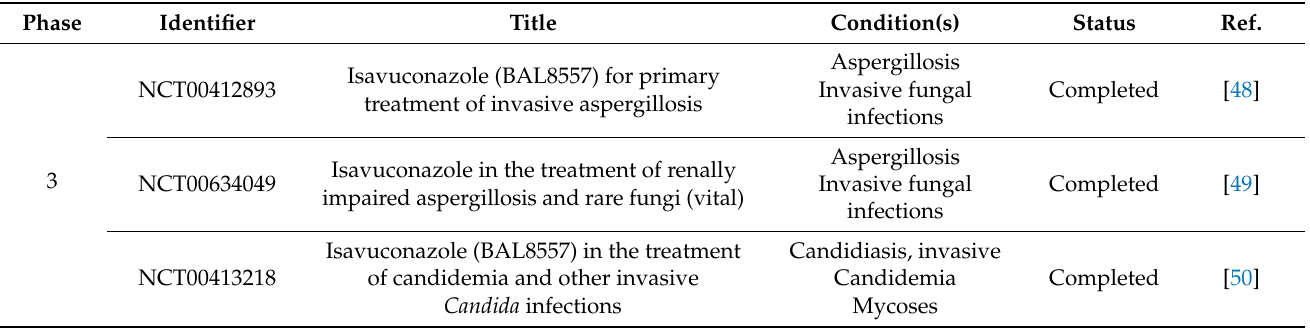
Table 2. Mentioned clinical trials for isavuconazole ( 3 ) (summarized).